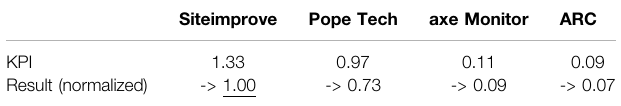
TABLE 5 | User Experience (empirical) results.